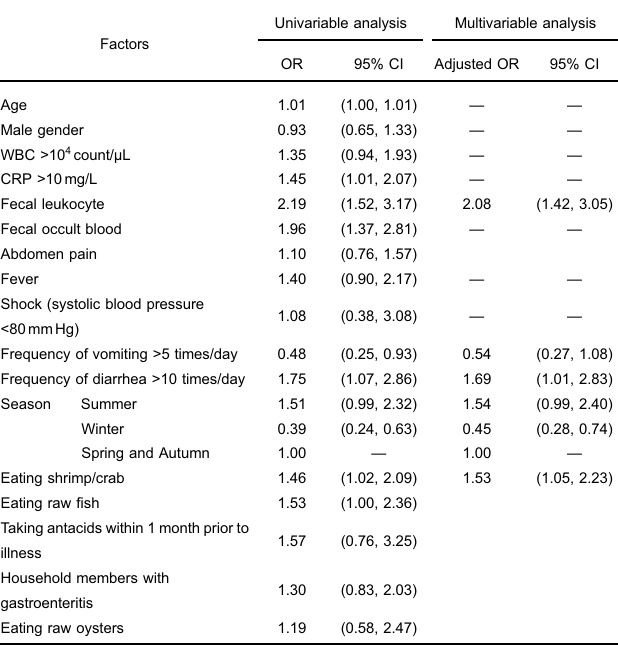
Table 6. Risk factors for bacterial gastroenteritis comparing with non-bacterial gastroenteritis